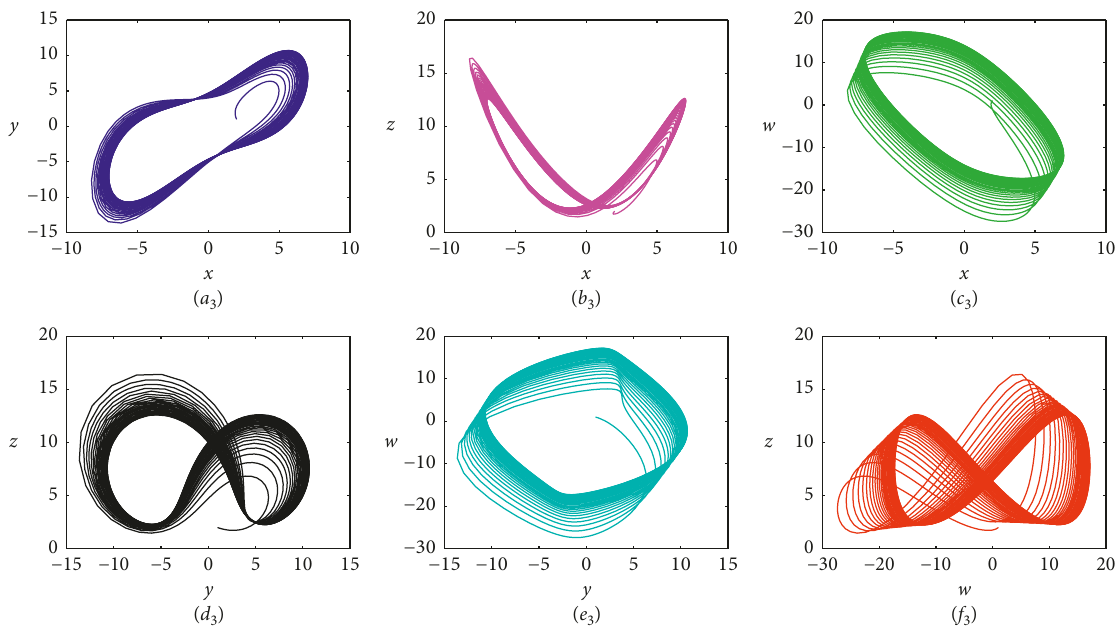
Figure 7: Phase portraits of Experiment 1 with a � 3 ,b � 5 ,t � 100: ( a y − z plane; ( e